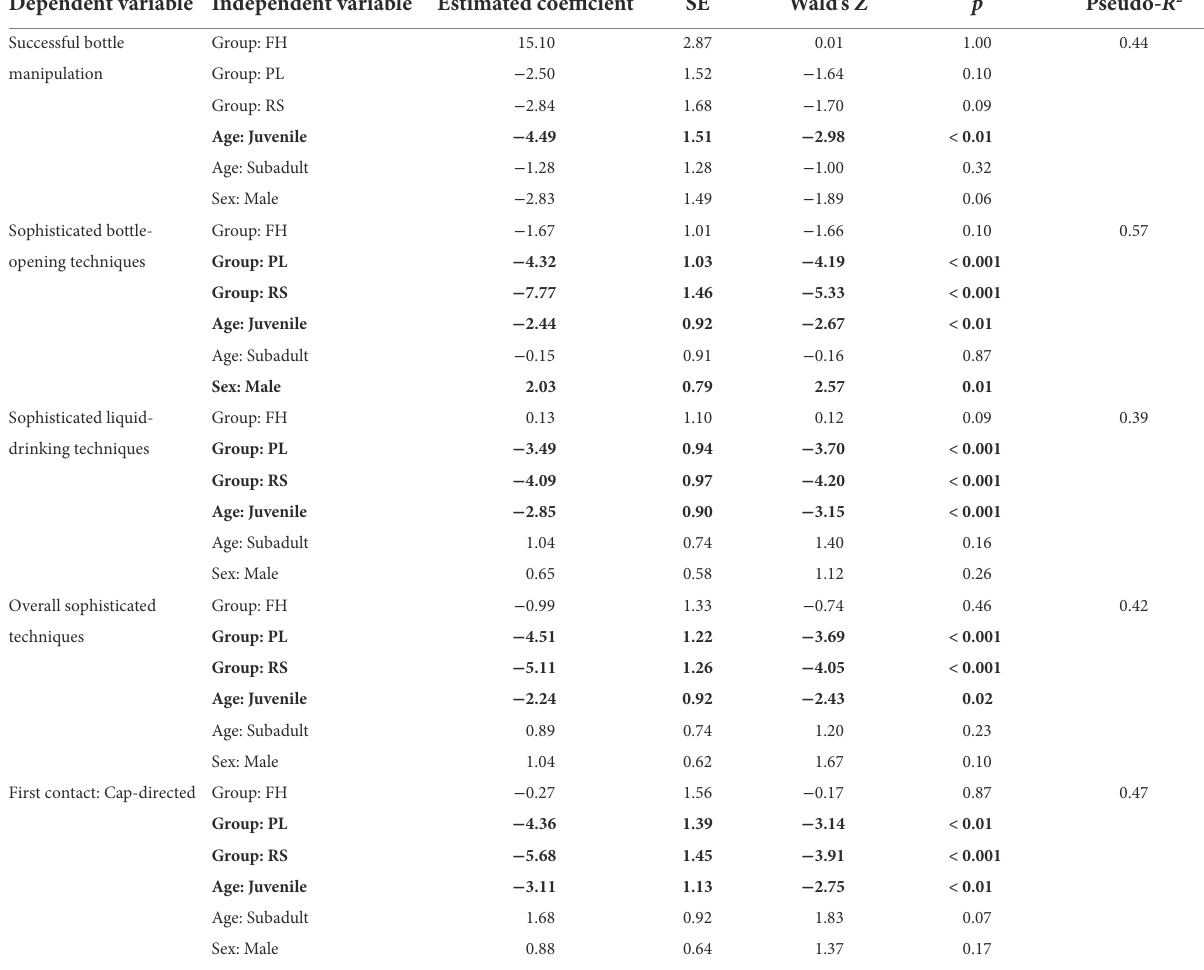
TABLE 6 Logistic regression analysis of the determinants of successful bottle manipulation and the occurrence of sophisticated bottle-directed techniques across all age-sex classes in the four study macaque groups during Task I. Dependent variable Independent variable Estimated